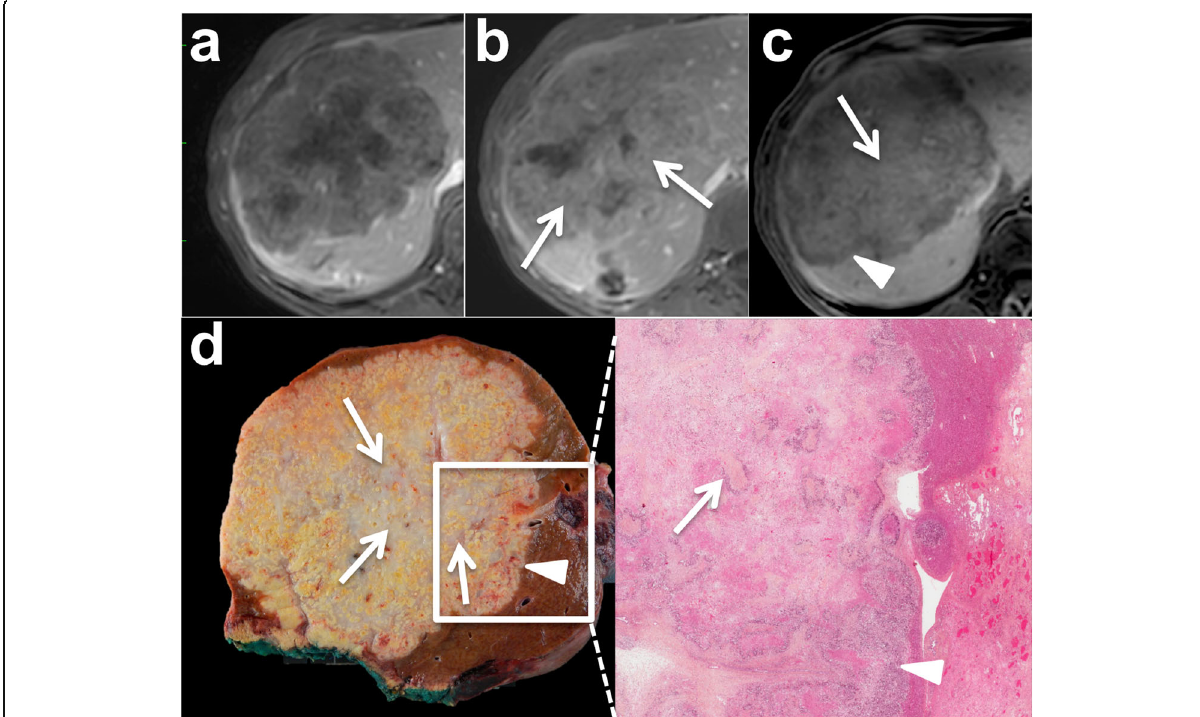
Fig. 5 Appearance of a fibrotic metastasis from non-otherwise specified (NOS) rectal cancer in a 54-year-old female patient. Gadobenate dimeglumine-enhanced fat suppressed gradient recall echo T1-weighted images obtained during portal venous ( a ) and delayed (3 min) ( b ) phases showed a 120 mm lesion in the right liver lobe characterized by a progressive enhancement of the central part, consistent with fibrotic tissue (arrows). The lesion showed central contrast retention on hepatobiliary phase images obtained after 120 min ( c ) (arrow) and a peripheral hypointense rim (arrowhead) corresponding to the “ target appearance. ” Gross pathology and histology analysis ( d ) confirmed the presence of large areas of necrosis and fibrotic bands (arrows) intermingled within the lesion; note the pushing proliferative pattern with peripheral tumoral growth